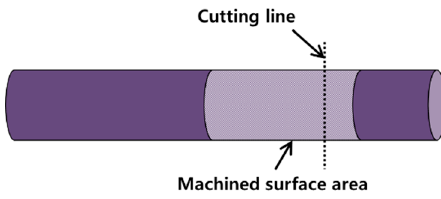
Figure 4. Cutting area of cylindrical workpiece.